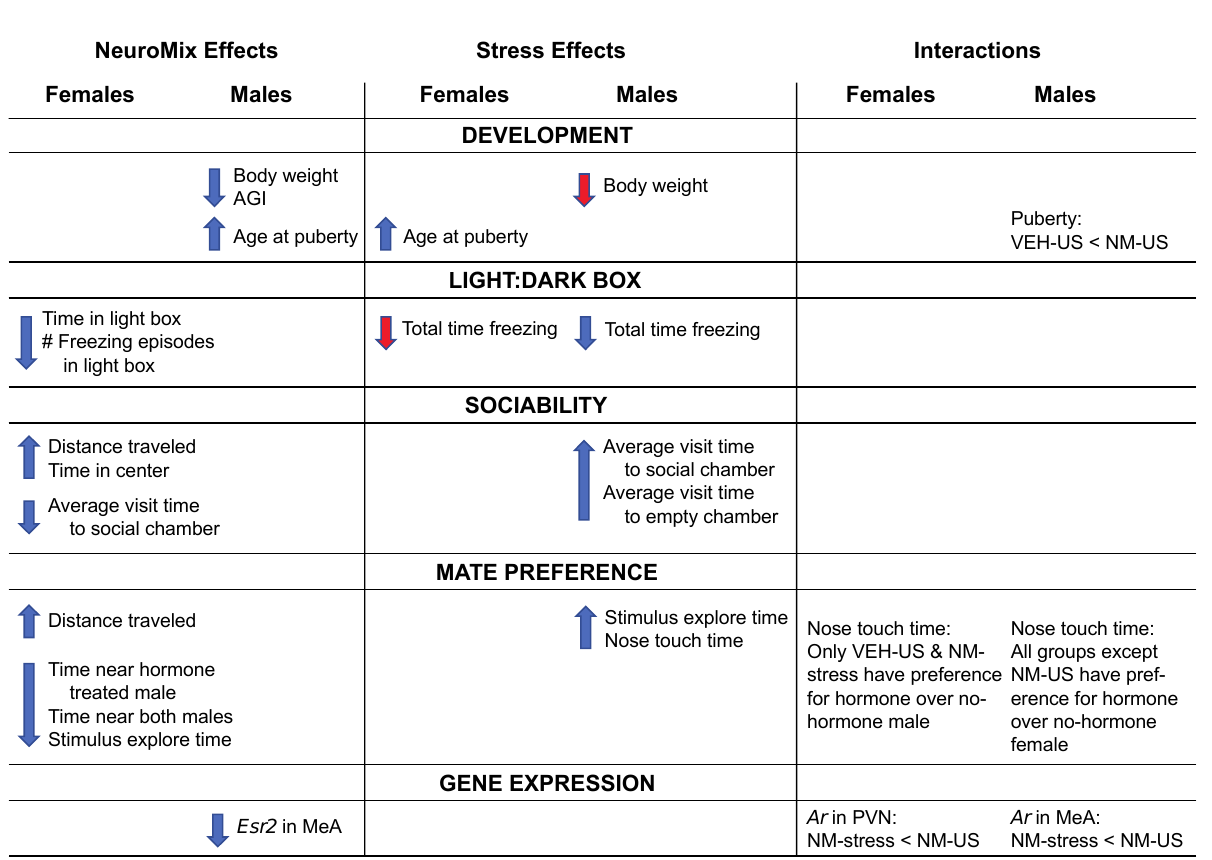
Figure 8. Schematic of overall outcomes of prenatal NeuroMix exposure, stress during adolescence, and their interactions. Down-arrows indicate decreases caused by NeuroMix vs. vehicle or stress vs. no stress. Up-arrows indicated increases caused by NeuroMix vs. vehicle or stress vs. no stress. Significant differences (at p < 0.05) are indicated by blue arrows, and trends (0.05 < p < 0.1) are indicated by red arrows. US: unstressed; NM: NeuroMix; VEH: vehicle; PVN: paraventricular nucleus; MeA: medial amygdala; AGI: anogenital index.